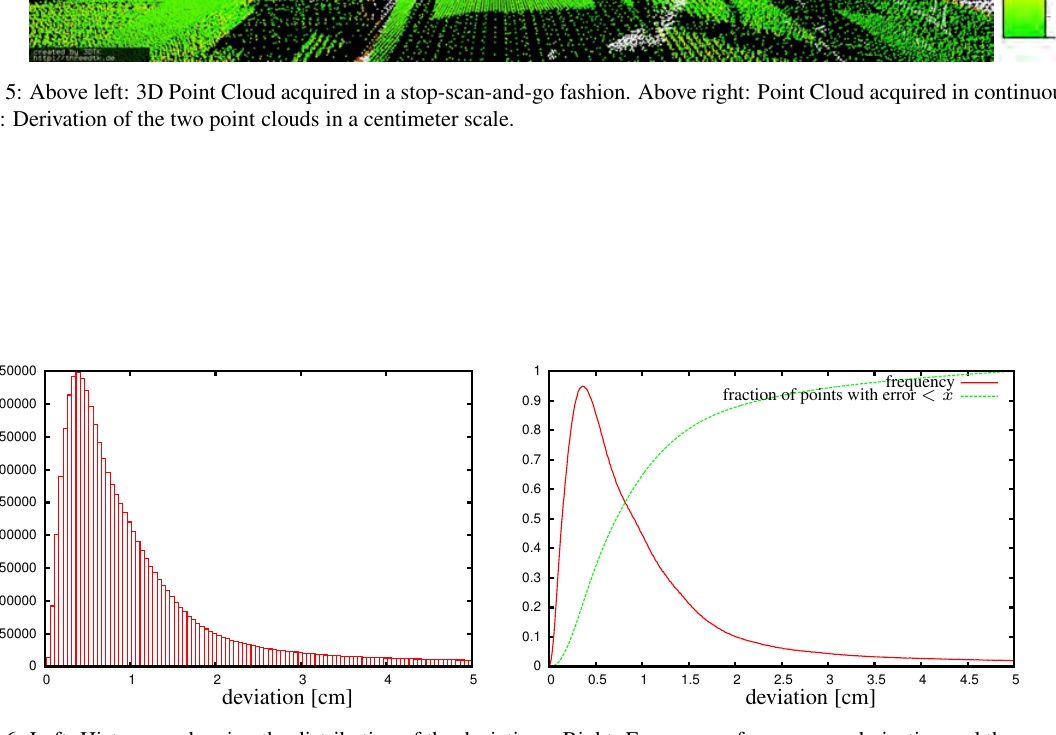
Figure 6: Left: Histogram showing the distribution of the deviations. Right: Frequency of occurrence derivation and the corresponding fraction of points with the error smaller than x